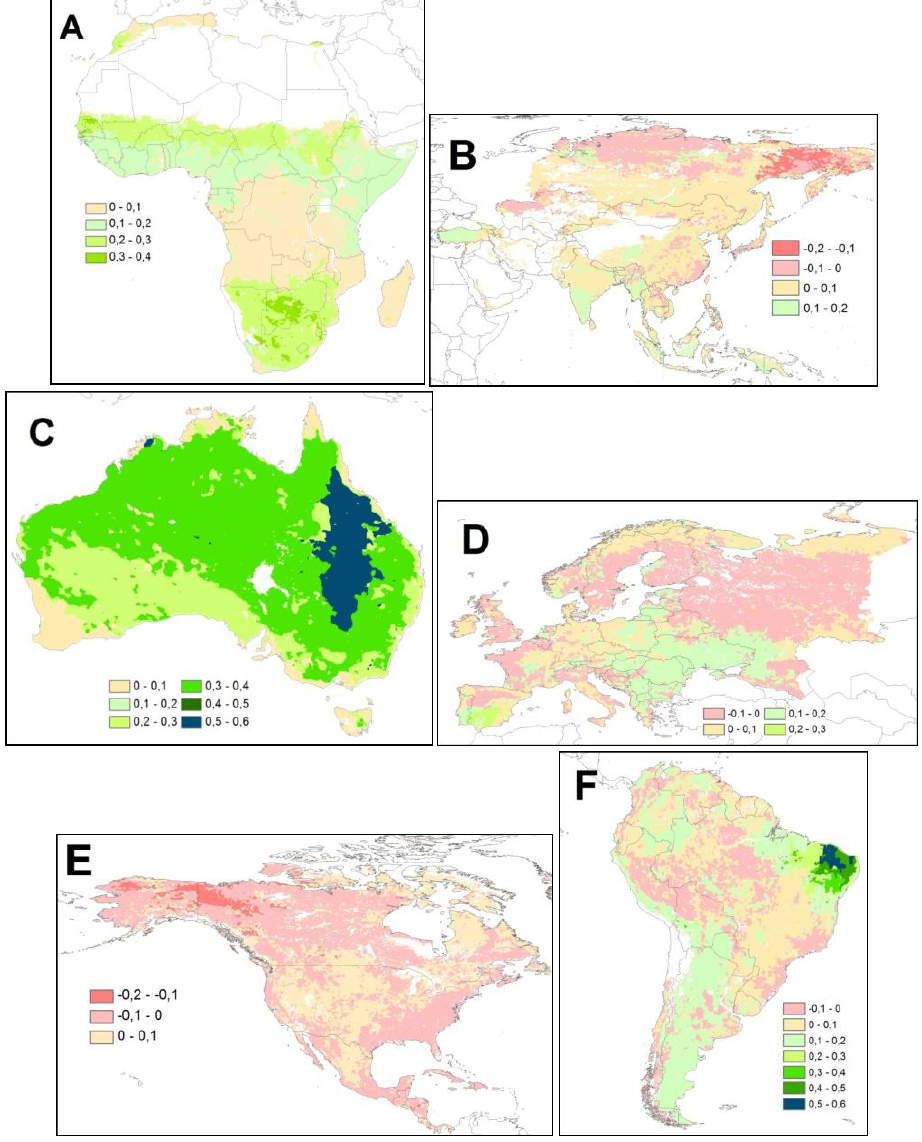
Figure 4. Pearson’s r-values between the FPAR3g anomalies and the ERTs average SPEI12 profiles. ( A ) Africa, ( B ) Asia, ( C ) Australia, ( D ) Europe, ( E ) North America and ( F ) South America.